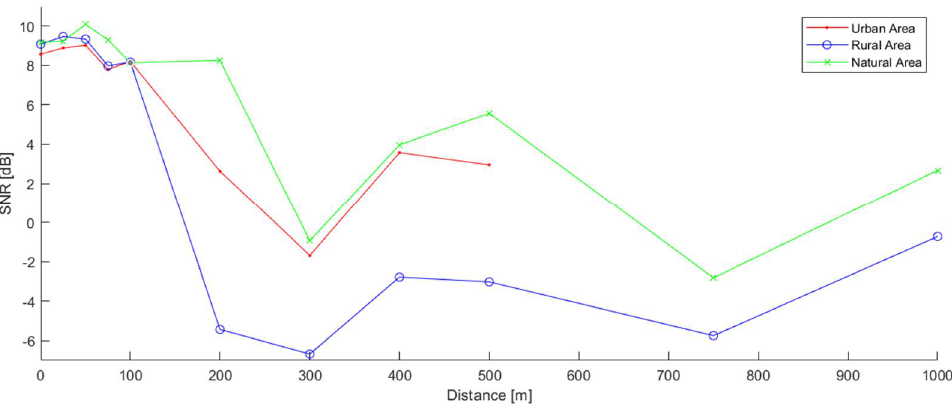
Figure 12. Comparison of experimental SNRs as a function of distance.